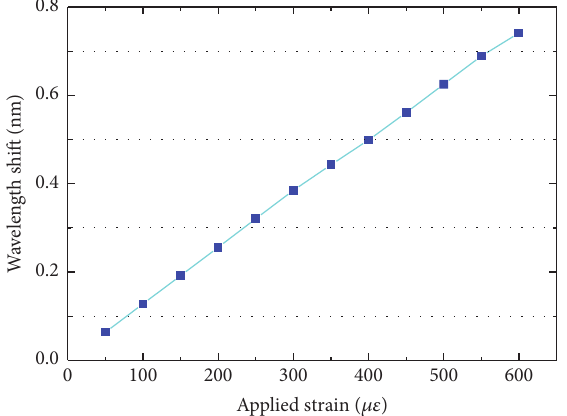
Figure 11: Wavelength shifts versus the applied strain.